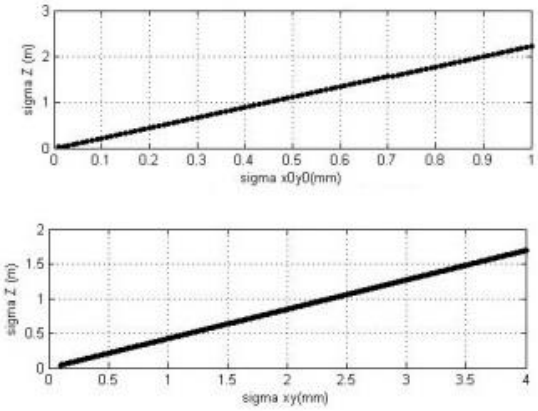
Figure 5.c-2 Effect of orientation parameters to on component Z